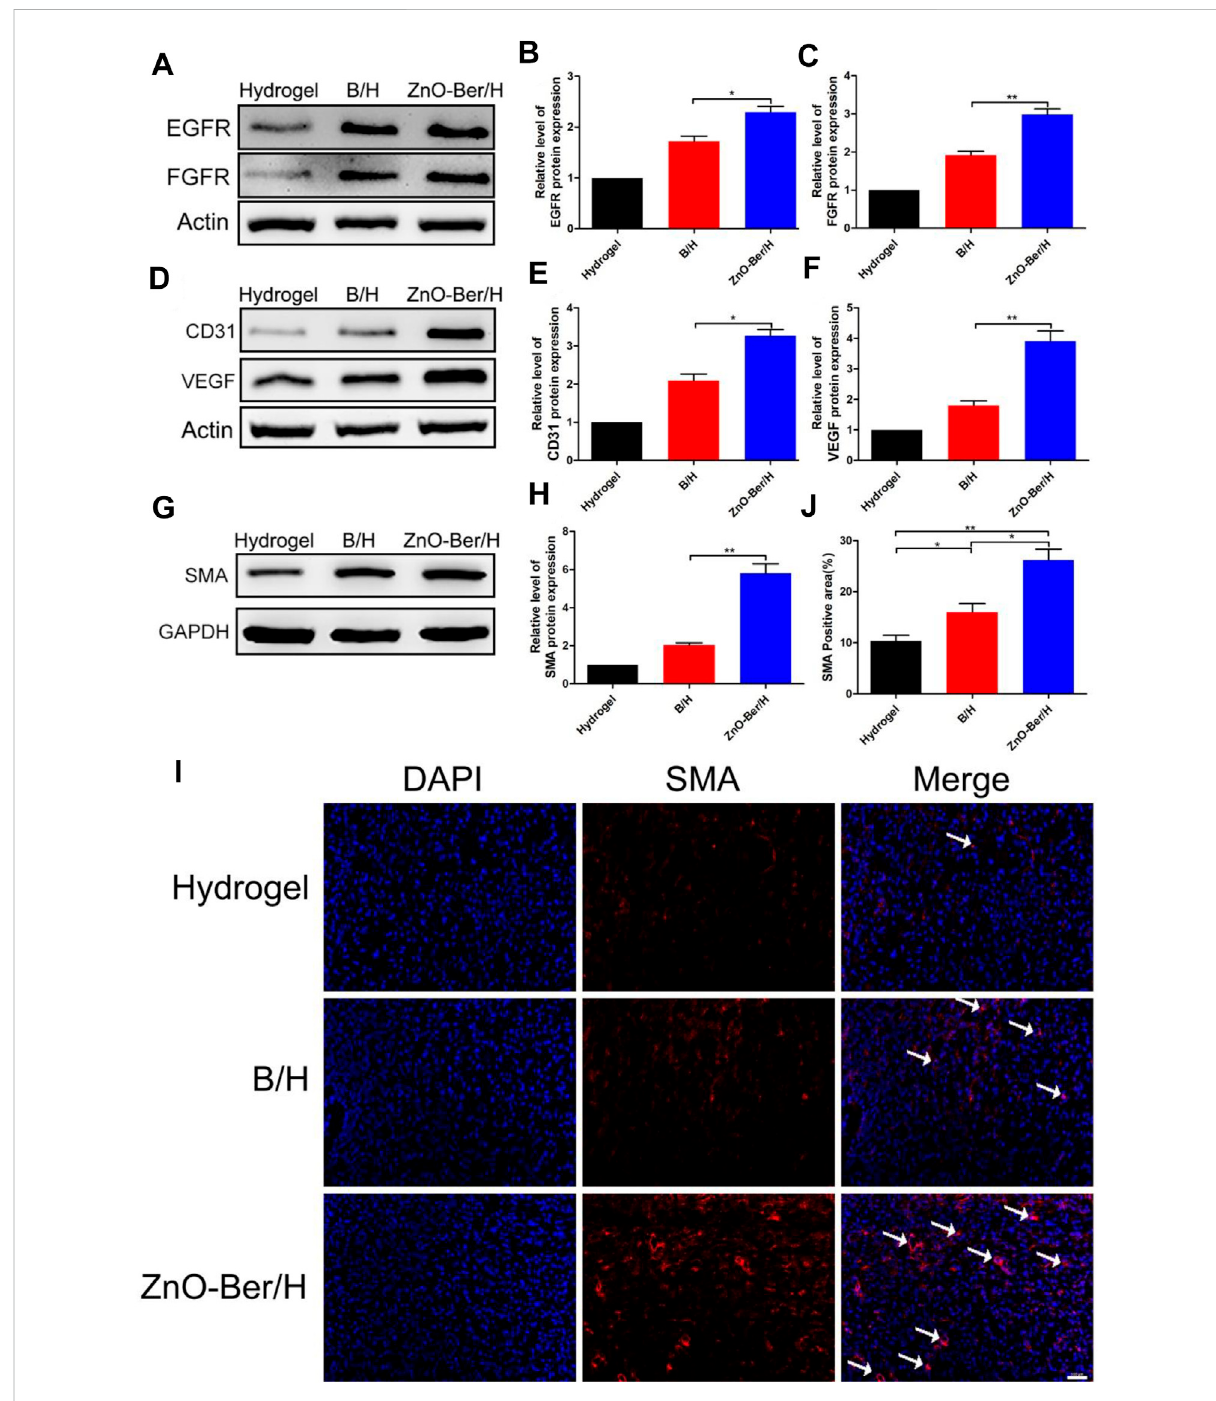
FIGURE 6 ProteinexpressionofEGFR,FGFR,SMAandAKT/p-AKTinwoundhealing. (A) WesternblotexpressionofEGFRandFGFRproteins. (B,C) Western blot expression analysis of EGFR and FGFR. (D) Western blot expression of CD31 and VEGF proteins. (E,F) Western blot expression analysis of CD31 and VEGF. (G) Western blot detection of expression of SMA protein. (H) Western blot expression analysis of SMA. (I) Immuno fl uorescence of SMA expression. (J) The relative expression analysis of SMA. Statistical analysis: *p ≤ 0.05, **p ≤ 0.01. Scale bar: 100 μ